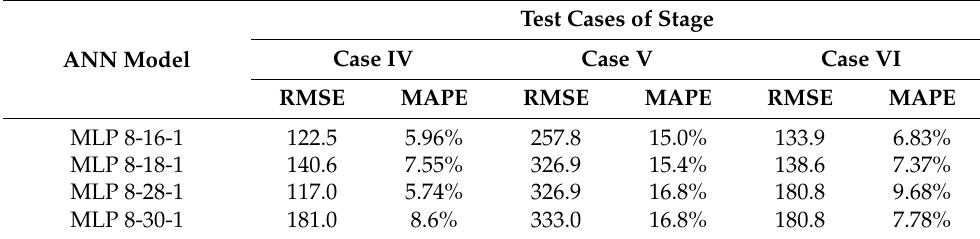
Table 8. Statistical values of neural network models for verification